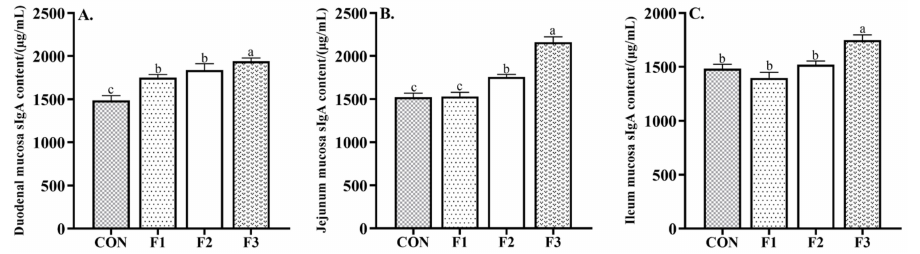
Figure 3. Effects of dietary fucoidan supplementation on intestinal mucosal immunity in weaned goat kids. ( A ) Duodenal mucosa sIgA content; ( B ) jejunum mucosa sIgA content; ( C ) ileum mucosa sIgA content. Results are presented as mean ± SEM. a–c means significantly different ( p < 0.05). CON, basal diet; F1, basal diet + 0.1% fucoidan; F2, basal diet + 0.3% fucoidan; F3, basal diet + 0.5% fucoidan. sIgA, secretory immunoglobulin A.